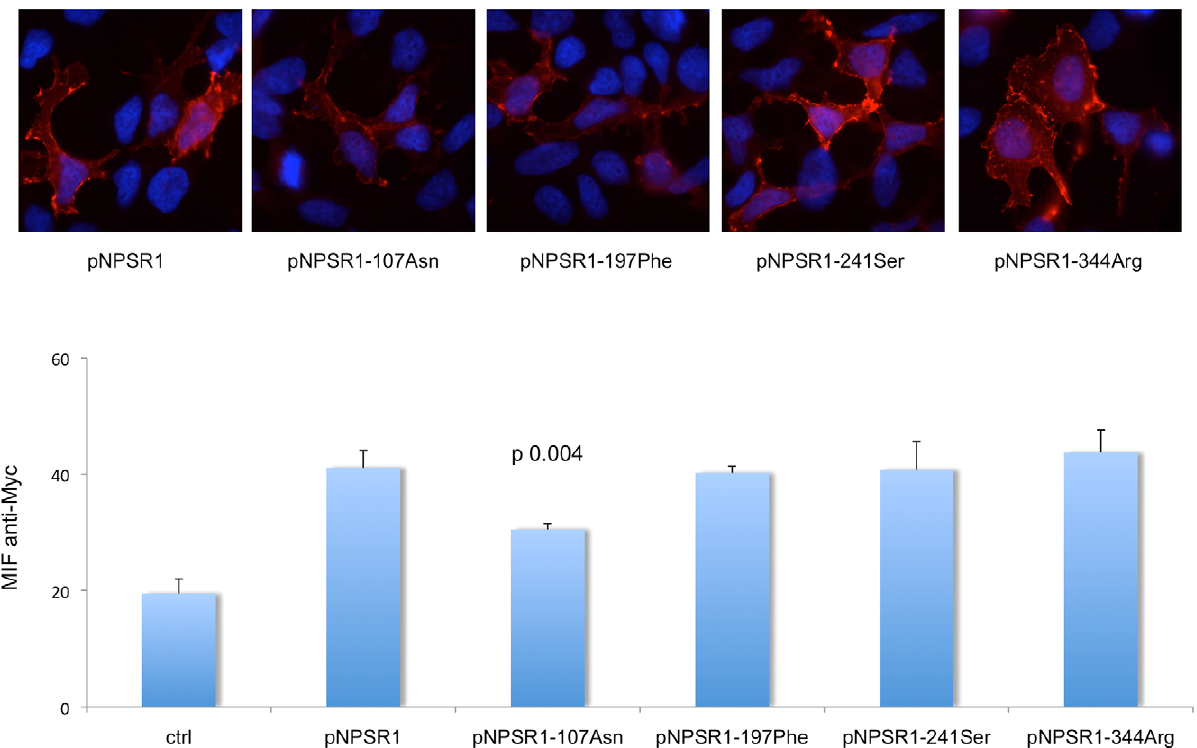
Figure 3. Membrane expression of NPSR1 coding variants. Top: HEK293 cells were transiently transfected with Myc-tagged NPSR1 expression vectors corresponding to different coding variants as indicated, and stained with anti-Myc antibody (red) and Hoechst 33258 (blue). Bottom: FACS analysis of cell surface expression of NPSR1 coding variants HEK293 cells were co-transfected with GFP and either an empty vector (ctrl) or vectors carrying Myc-tagged cDNAs for NPSR1 and all coding variants as indicated. After gating for GFP, anti-Myc mean fluorescence intensity (MIF) was measured for each sample, and the results obtained in three independent experiments are reported in the graph. In these conditions, the expression of the pNPSR1-107Asn variant was significantly lower (t test) than that of pNPSR1, taken as reference for this series of